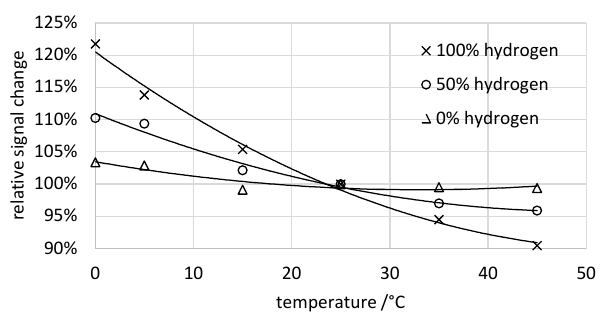
Figure 10. Temperature dependence of the sensor output voltage at different hydrogen